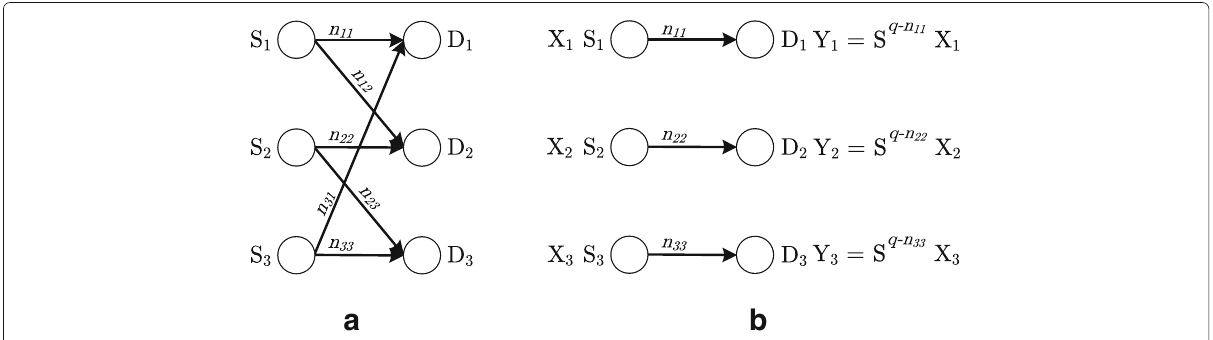
a b Fig. 2 a A network in which coding is required to achieve the normalized sum capacity and b the induced subgraphs original network by using only two time slots such that all nodes receive the same signal as if they were in the induced subgraphs. This would immediately imply that a normalized sum rate of 1 is achievable 1 . 2